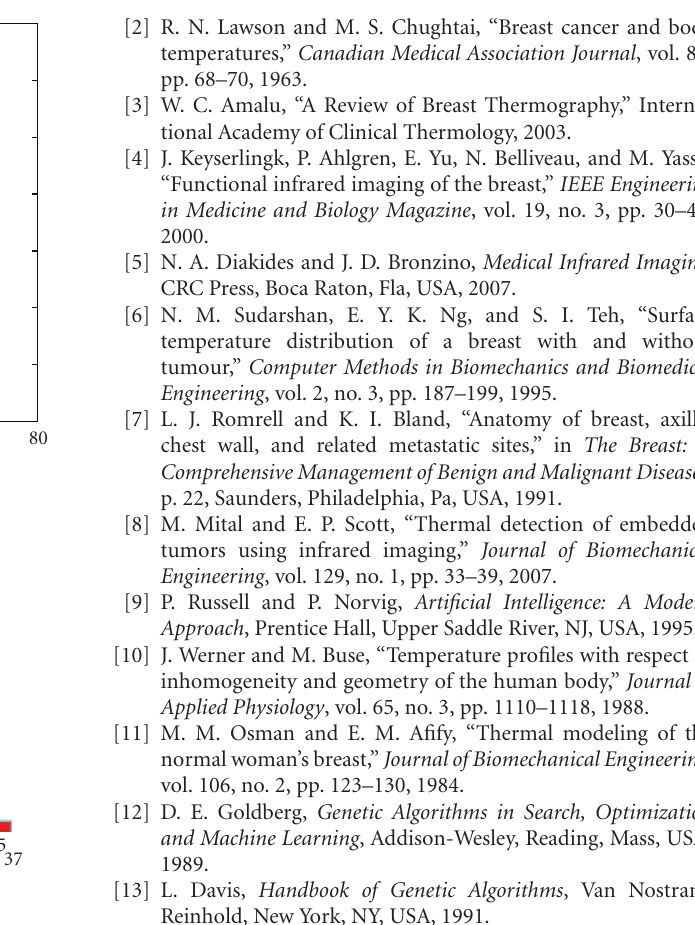
Figure 7: Comparison of temperature profile of trained ANN with direct numerical